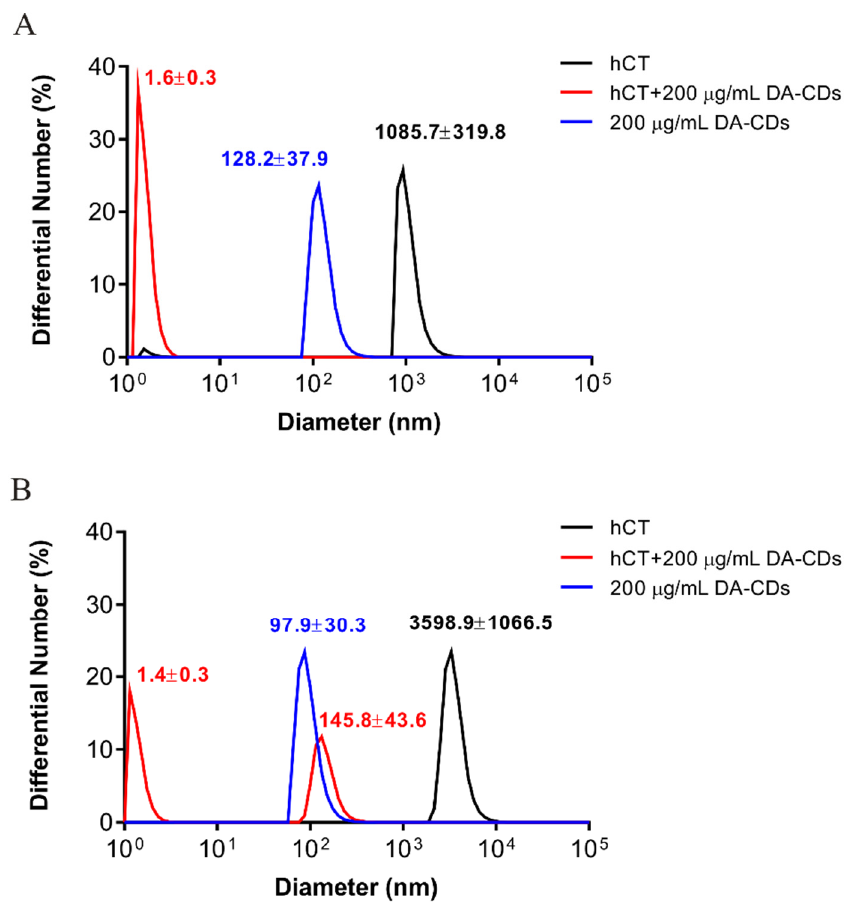
Figure 3. Particle distribution monitored by DLS. hCT alone (black), DA-CDs alone (blue), and hCT with DA-CDs (red) were individually incubated in microtubes and subjected to DLS at ( A ) 48 h and ( B ) 72 h.